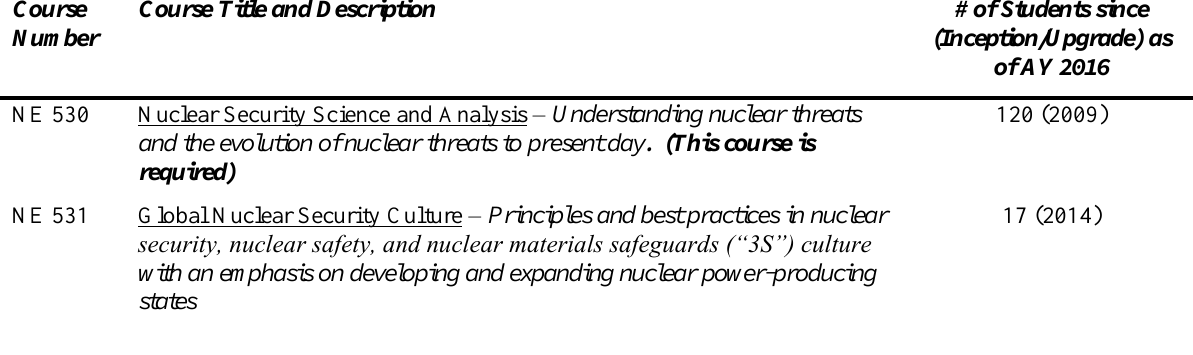
Table 1. Coursework qualifying for the UTNE NSSA